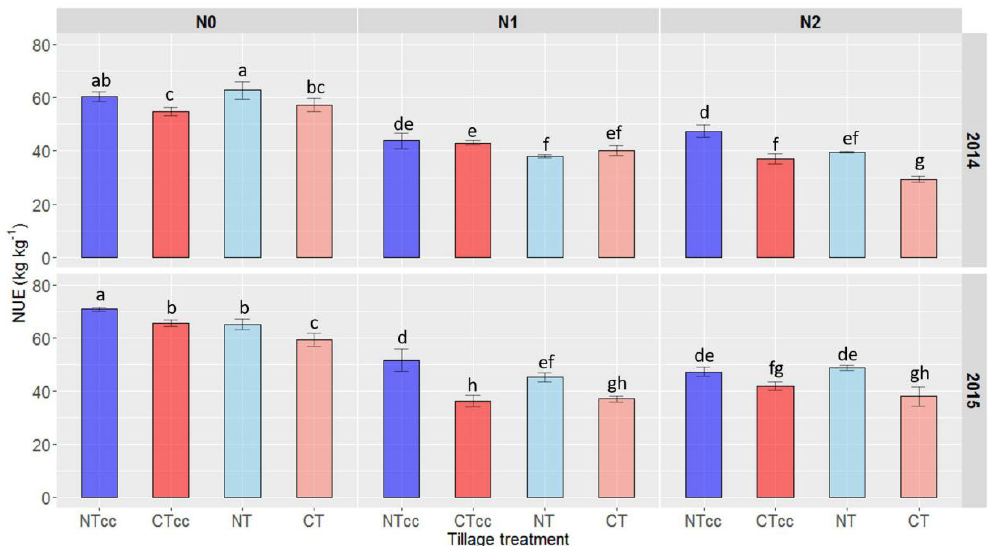
Figure 1. Effect of soil tillage treatment, cover crops and N application on NUE of wheat grown in 2014 and 2015. NTcc: No-till with cover crops. NT: No-till without cover crops. CTcc: Conventional tillage with cover crops. CT: Conventional tillage without cover crops. N0: no added N fertilization. N1: 161 kg N ha −1 . N2: 215 kg N ha −1 . Soil management practices (CT and NT) and N fertilization (N0, N1 and N2) were subjected to analysis of variance (two-way ANOVA, with tillage practice with or without cc and N fertilization as the two main parameters). Treatment means were compared using Duncan’s new multiple range test at a 95% family-wise confidence level. Means with the same letter are not significantly different across N fertilizer treatments.